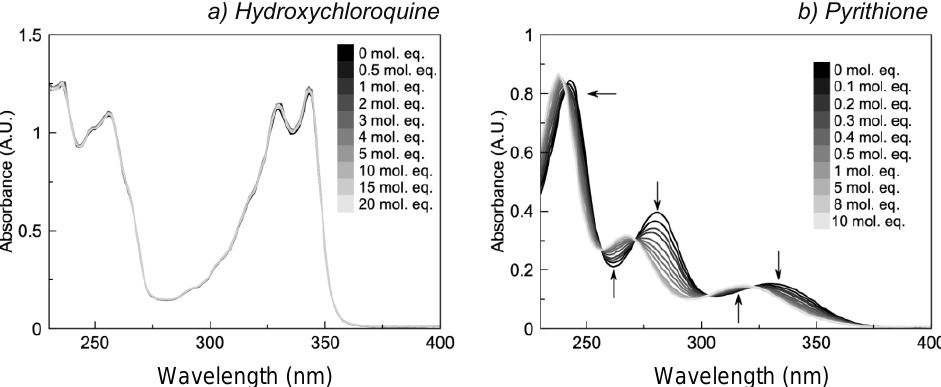
Figure 3. UV spectra of ( a ) HCQ and ( b ) pyrithione (5.01 × 10 −5 M in Tris-buffered water) solutions titrated with aliquots of ZnCl 2 in 0.1 molar equivalents. The final spectra for HCQ were 1:20 molar equivalents of drug to zinc.